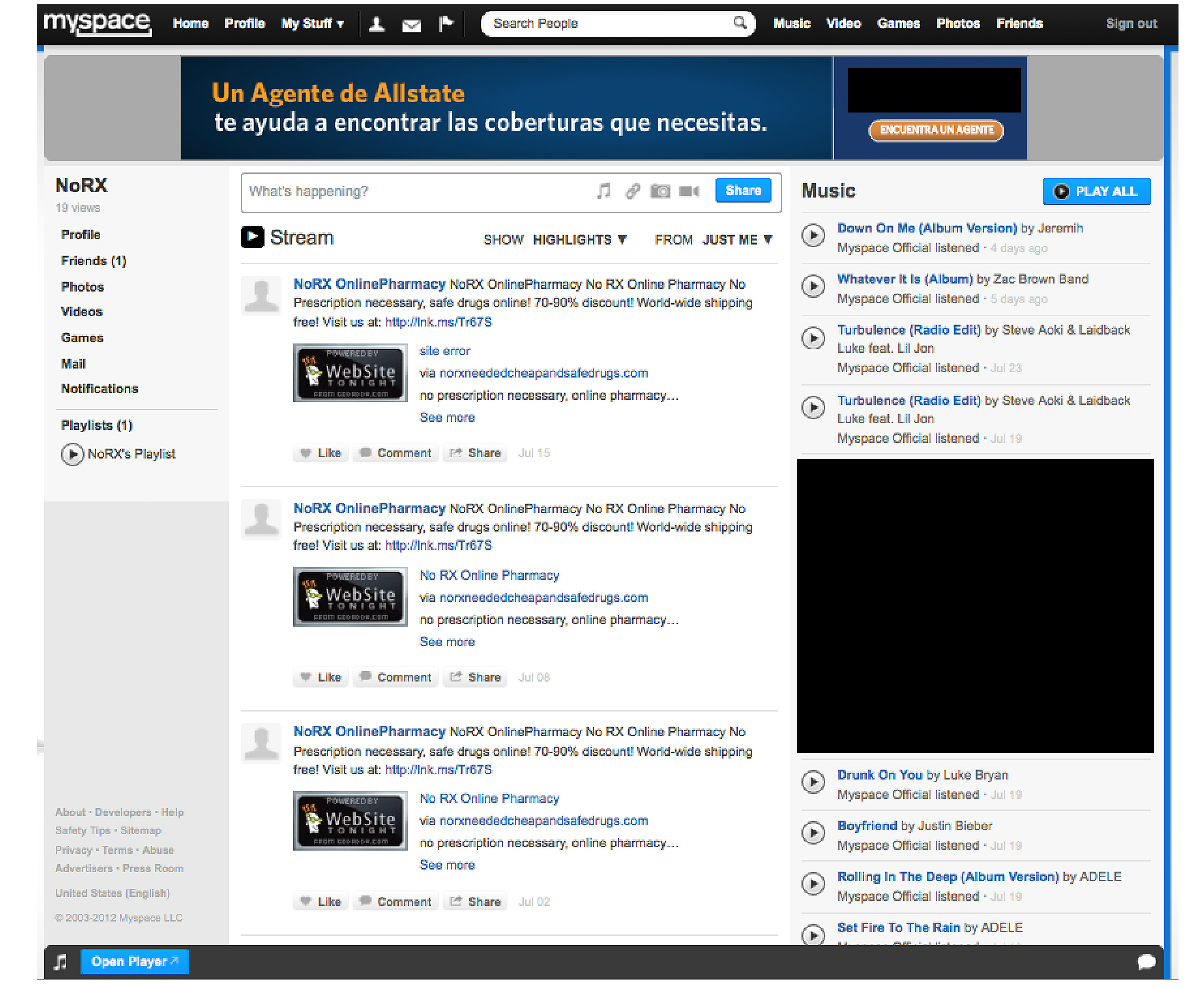
Figure 4. MySpace eDTCA